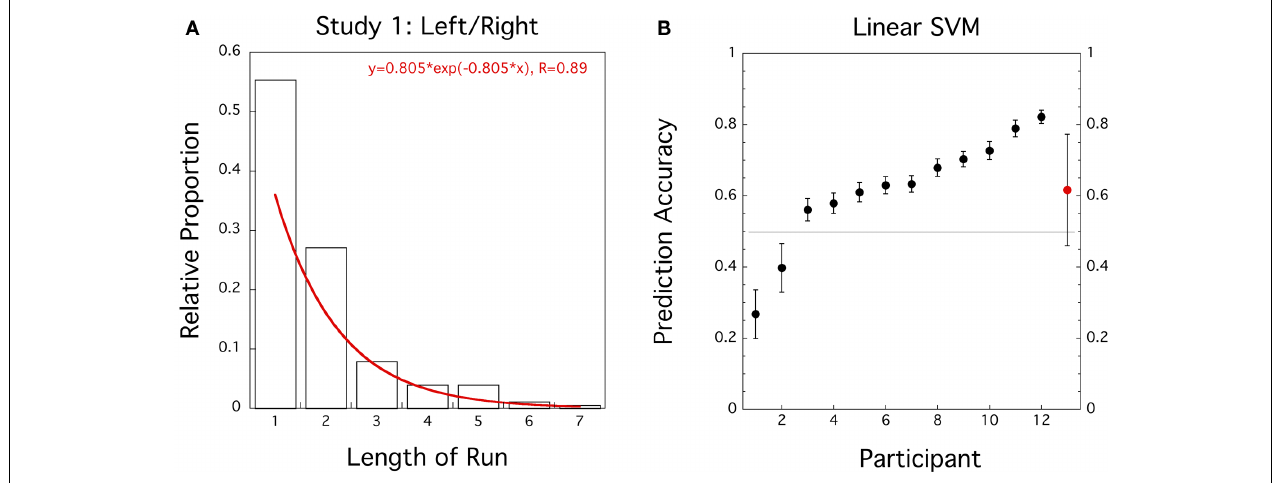
function. (B) Prediction accuracies of linear SVM trained on preceding and current responses for individual data sets (black circles, error bars =± 1 SD bootstrapped) and group average (red circle, error bar =± 1